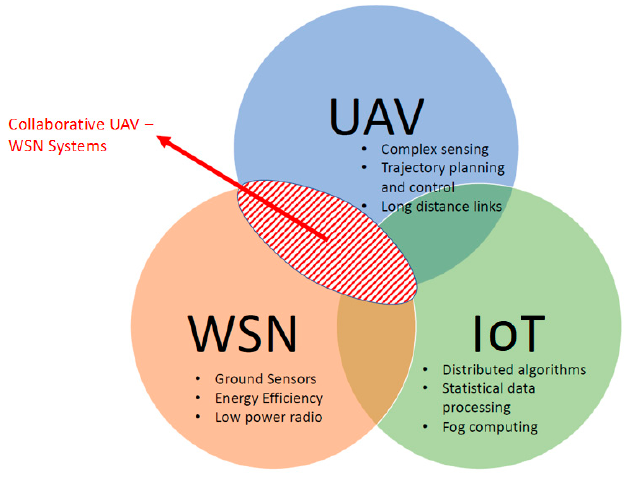
Figure 6. Research topics overlap in collaborative UAV and WSN systems with IoT aspects.